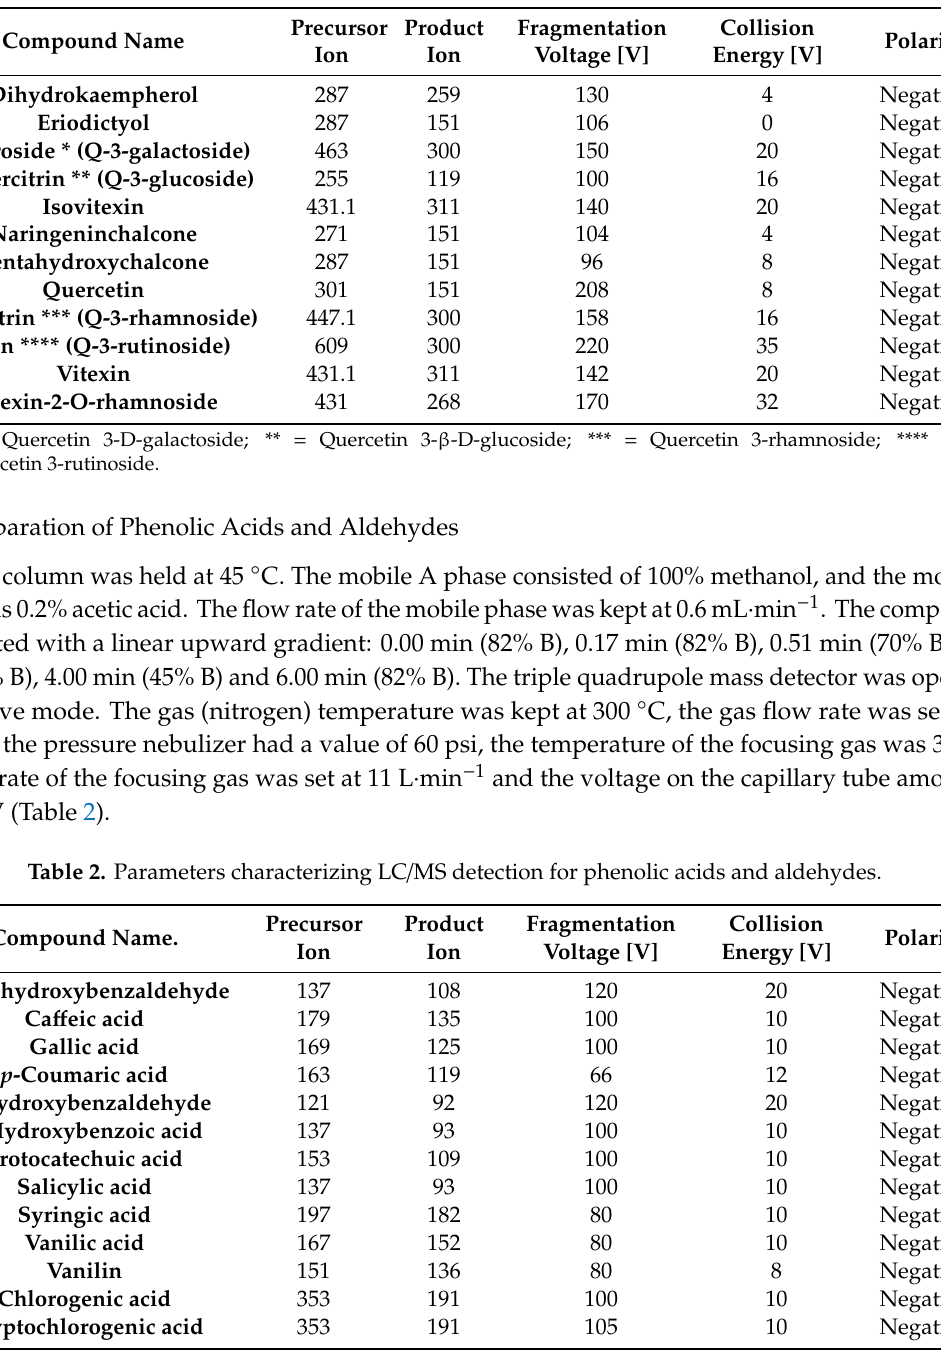
Table 1. Parameters characterizing LC / MS detection for flavonoid compounds.